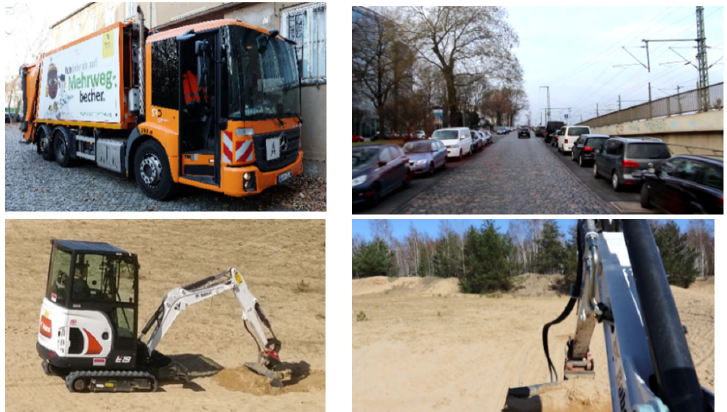
Figure 2. Commercial vehicle and driver’s view. Figures at the top: refuse collection vehicle on cobblestone; figures below: mini excavator on sand.